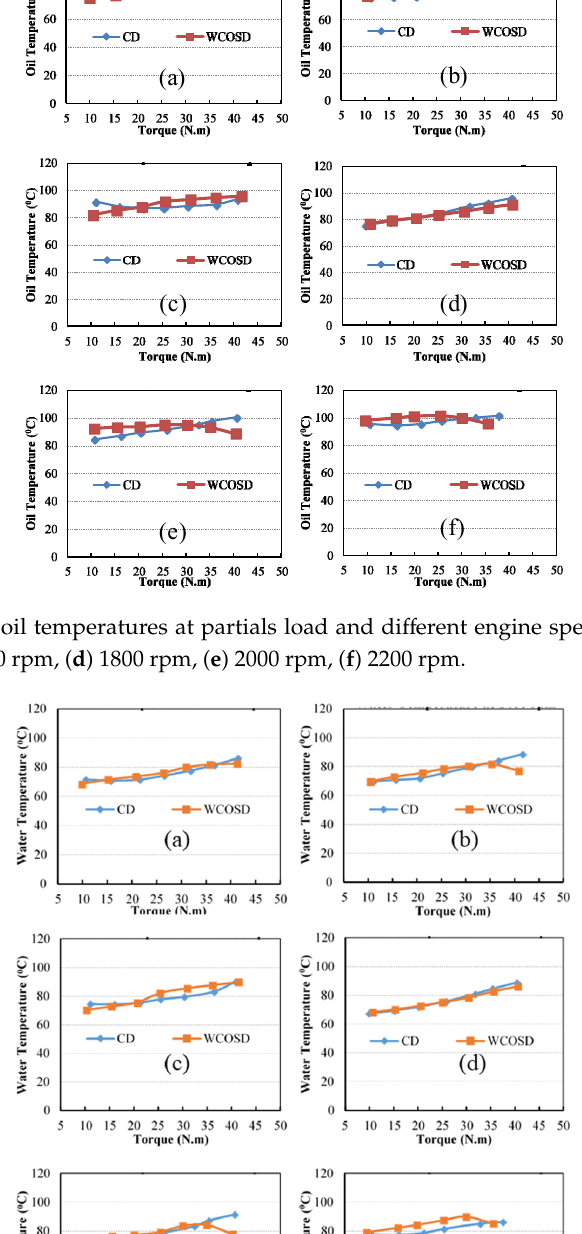
Figure 6. Lubricant oil temperatures at partials load and different engine speeds: ( a ) at 1200 rpm, ( b )